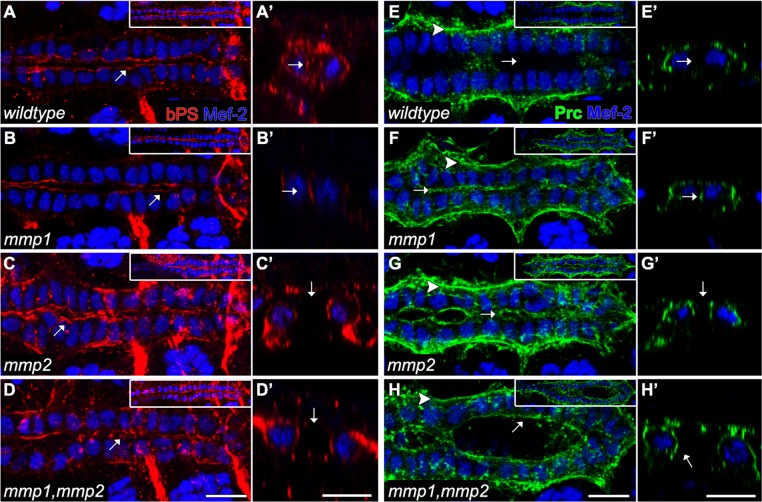
Apical and basal markers are mislocalised in mmp mutants.Wildtype and mmp mutant embryos labelled with α-βPS(A-D’, red), α-Prc (E-H’,green) and α-Mef2 (A-H’, blue) are shown from both (A-H) dorsal and (A’-H’) cross sectional views of the heart. (A-A’) In wildtype, βPS localises to the luminal domain (arrow). (B-B’) In mmp1 mutant embryos, βPS is localised to the reduced lumen (arrow). (C-D’) In mmp2 and mmp1,mmp2 mutant embryos, βPS covers the entire medial apical surface of the CBs (arrow). (E-E’) In wildtype, Pericardin localises exclusively to the basal domain (arrowhead). In mmp1 (F-F’), mmp2 (G-G”) and mmp1,mmp2 (H-H’) mutants, Prc localises to the entire medial surface (arrow) as well as the basal side (arrowhead) of the CBs. Scales—10 μm.